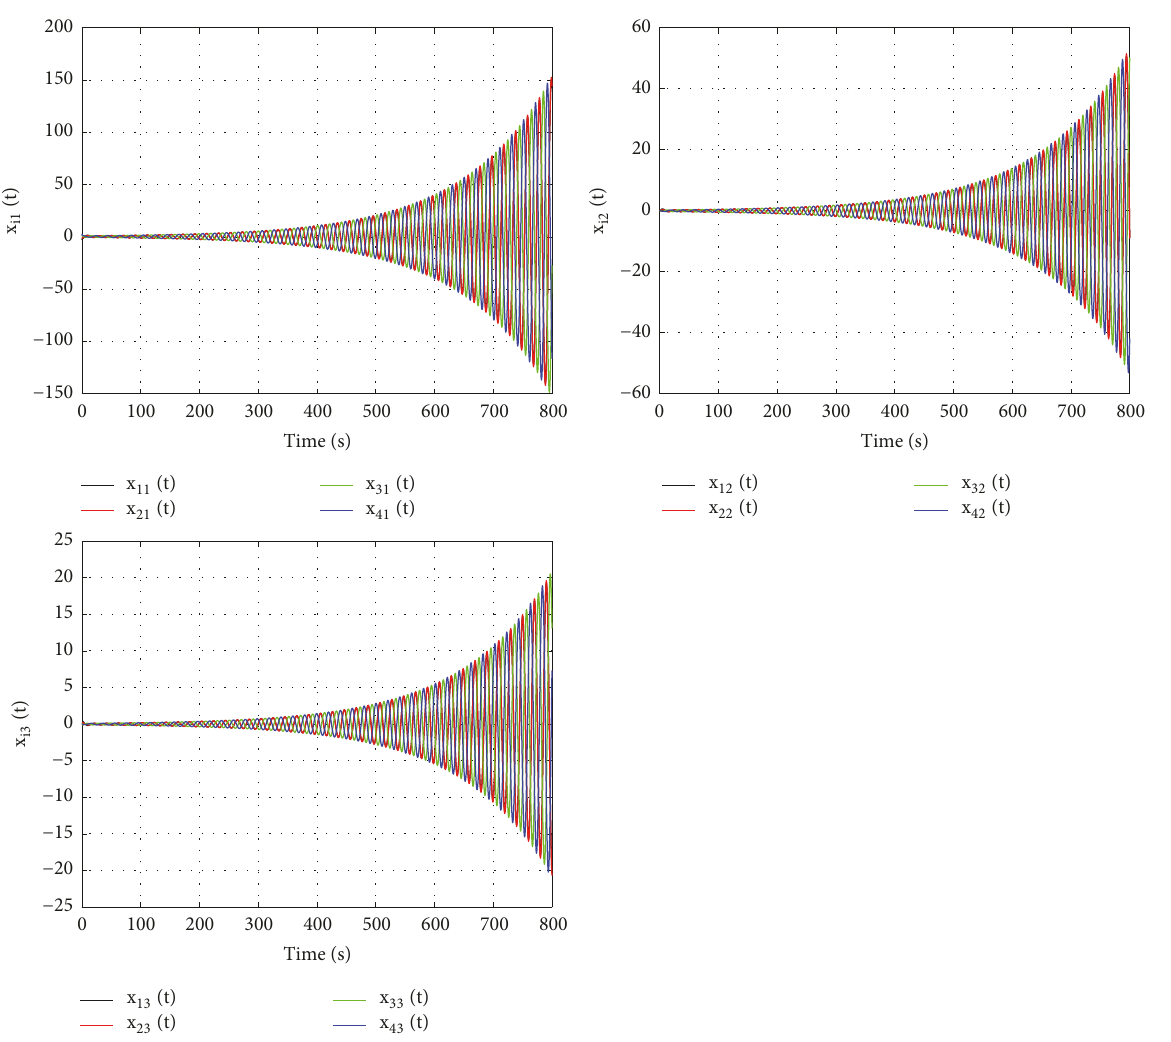
Figure 12: The trajectories of all agents’ states in the FOMAS with triple integral and asymmetric time-delays when all 𝜏 𝑚 > 𝜏 in Example